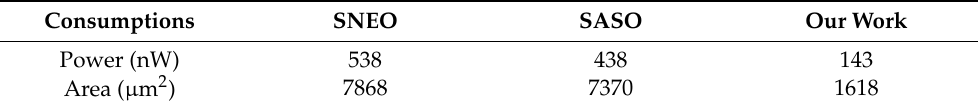
Table 3. Electrical consumptions of single channel spike detectors: SNEO, SASO and our work. Consumptions SNEO SASO